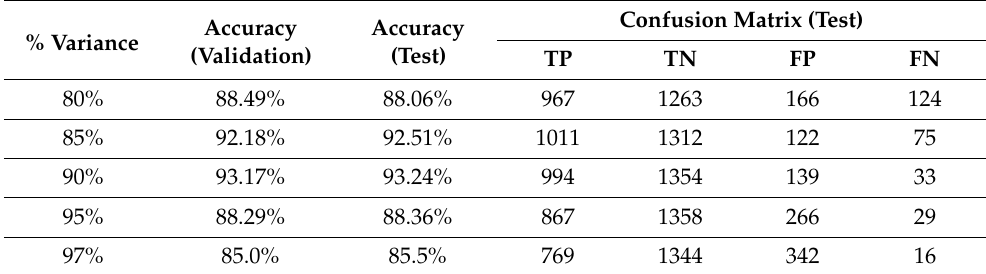
Table 4. Results of the SVM classifier for different PCA variance after holdout